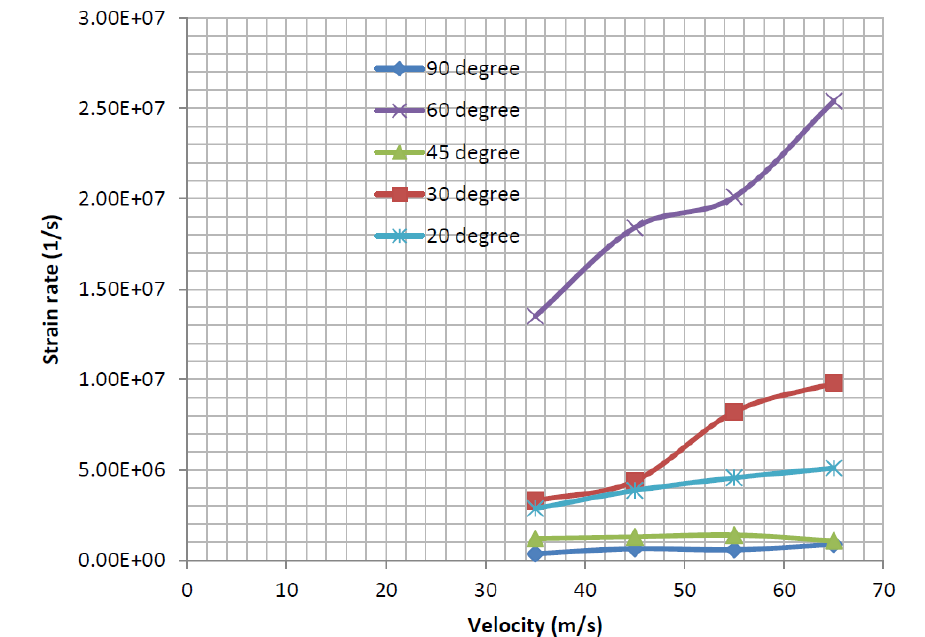
Figure 11: Strain rate vs. wind velocity curve for glass fibre